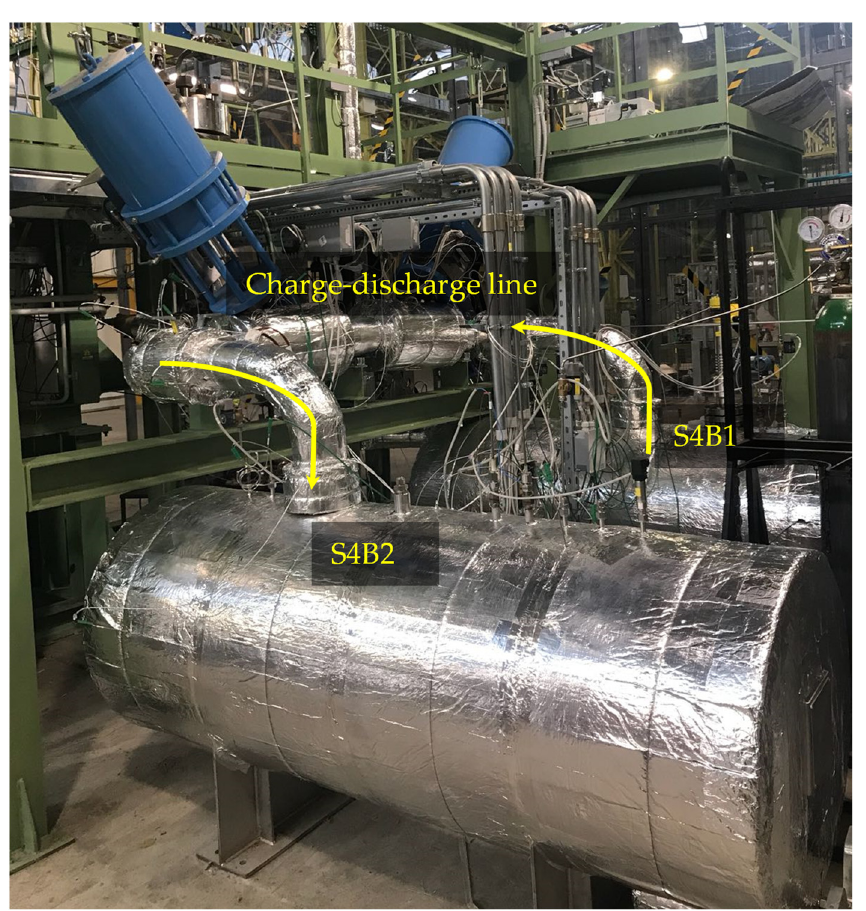
Figure 6. Storage (S4B1) and drain (S4B2) tanks, loading and discharge lines.